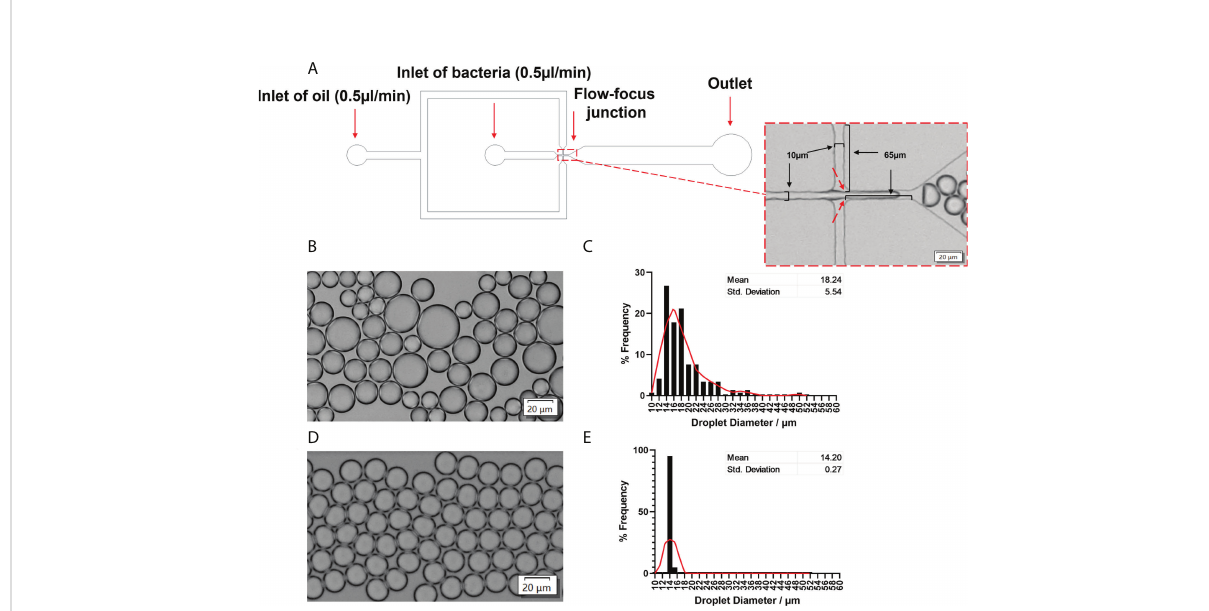
FIGURE 2 Micro fl uidic device to generate stable and uniform droplets. (A) Channel dimensions of the micro fl uidic chip. The dotted rectangle insert showed the bright- fi eld image of the fl ow-focusing junction. A bacterial solution was the disperse phase, and oil was the continuous phase. Droplets were produced at the fl ow-focusing junction (indicated by red arrows). (B) Bright- fi eld images and (C) the frequency distribution of droplet sizes produced by 2% Span80 in mineral oil. The average diameter was 18.24 ± 5.54µm. (D) Bright- fi eld images and (E) the frequency distribution of droplet sizes produced by 5% Span80 in mineral oil. The average diameter was 14.20 ± 0.26µm. 94.2% of droplets diameter values fell into the bin of 14.05 µm. Randomly selected 150 droplets were measured using the cellSens imaging software. The relative frequency distribution (percentage) was analysed using GraphPad Prism 8.3.0(538). The red Lowess curve showed the trend of the